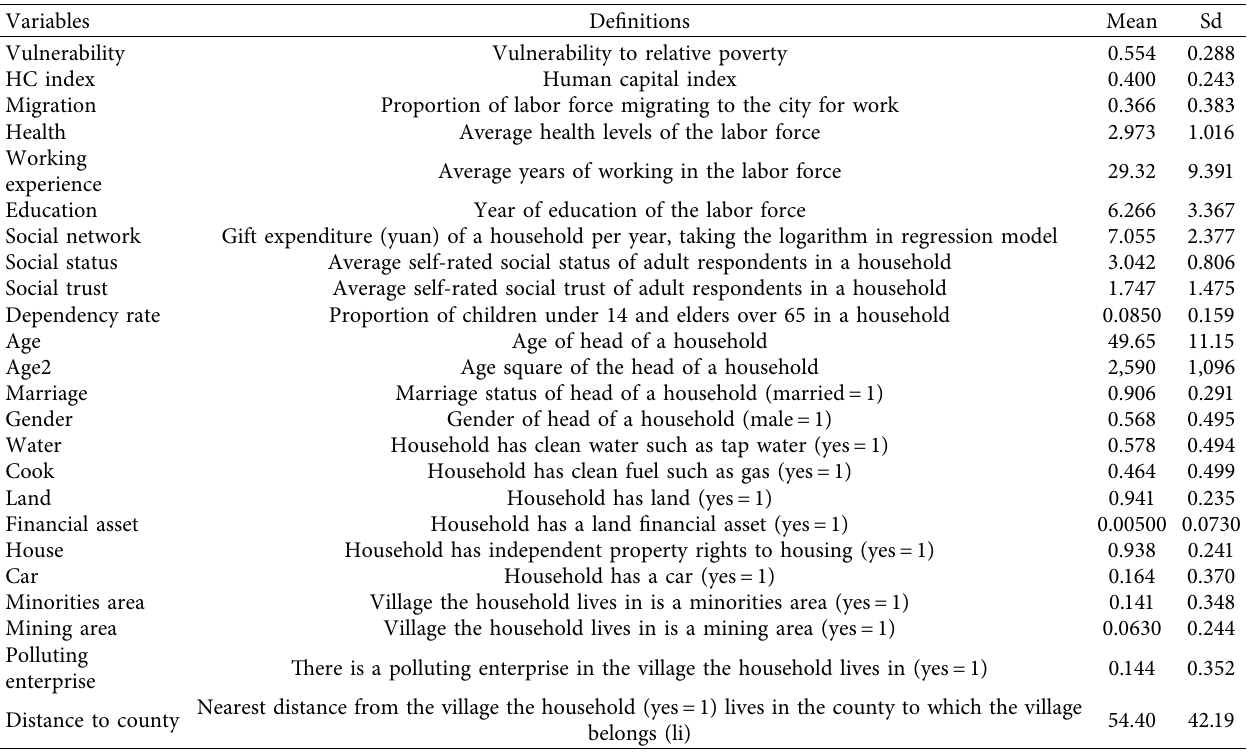
Table 1: Summary statistics.